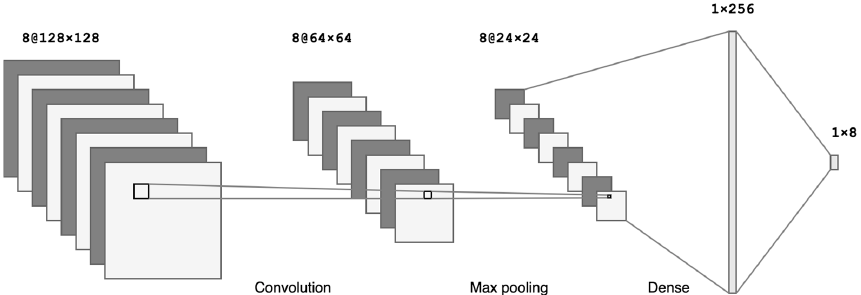
Figure 2. CNN network with three convolutional layers with max pooling and one dense layer and classification output.